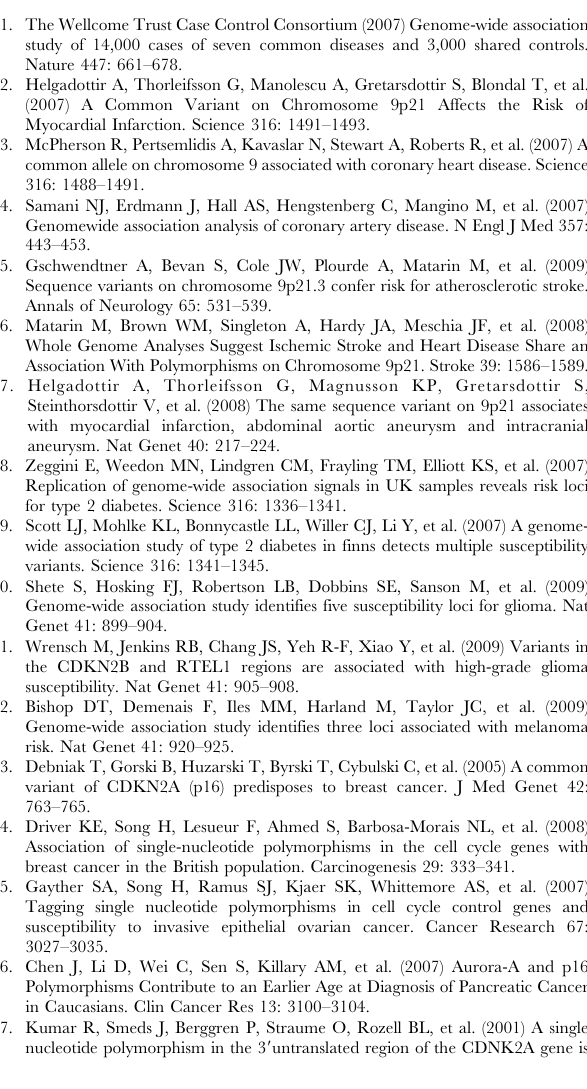
Table S4 Comparison of allelic expression normalisation ratios obtained from genomic DNA and experimental equimolar mixtures. Table S2 Effect size and significance of association for SNPs associated with disease. Data shown are for aeQTL mapping in Table S5 Comparison of variances between total expression and the combined population. Effects are reported as fold changes in allelic expression measurements in the SA expression for individuals who are homozygous for the minor allele relative to individuals who are homozygous for the major allele (calculated from allelic expression data using two transcribed SNPs per gene). Association for each SNP is presented as the 2 log 2 log 10 P-value and the 10 of the family wise error rate (FWER) using a Bonferroni correction for the 56 SNPs tested. Associations that were significant using a FWER threshold of 0.05 (corresponding to 2 log 10 P of 3.05, or 2 log 10 FWER of 1.3) were regarded as significant.